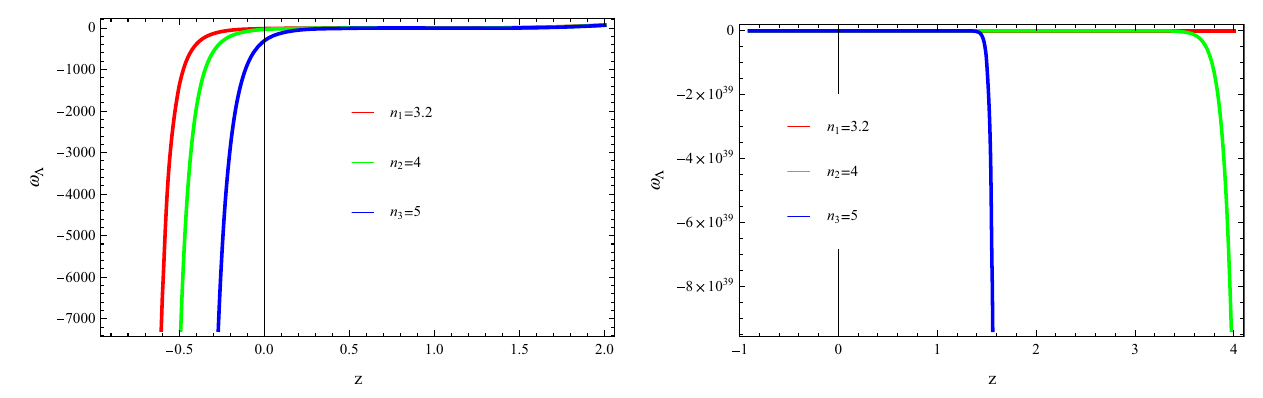
Fig. 3 Plots of power-law EoS parameter ω (cid:3) for u = 2 (left) and u = − 2